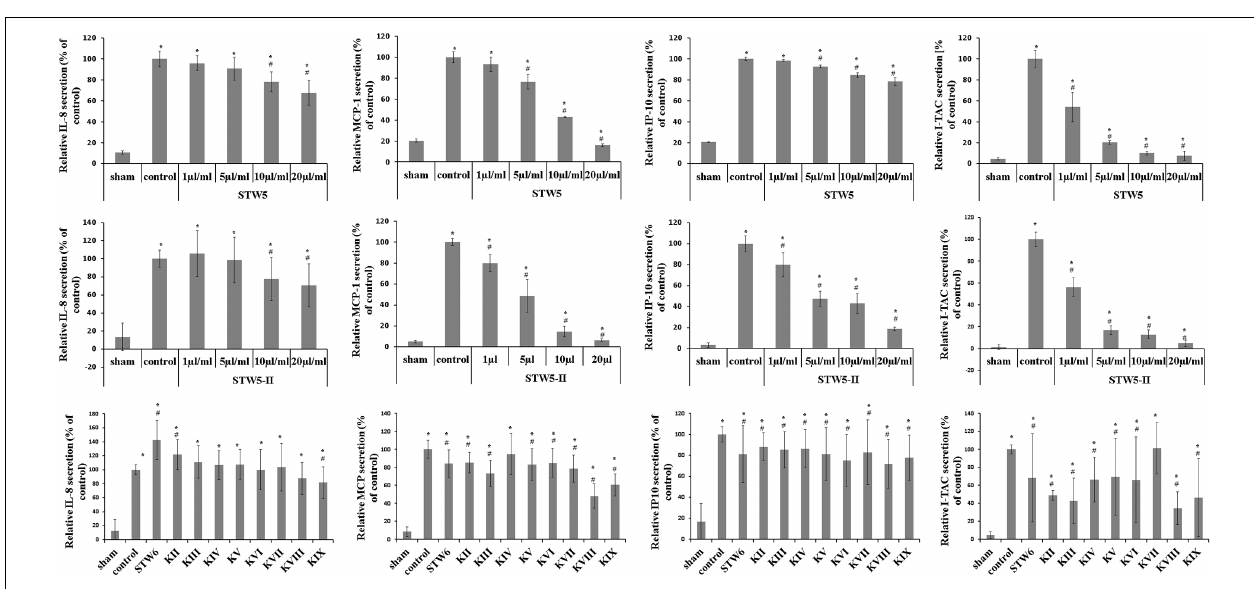
Frontiers in Pharmacology |